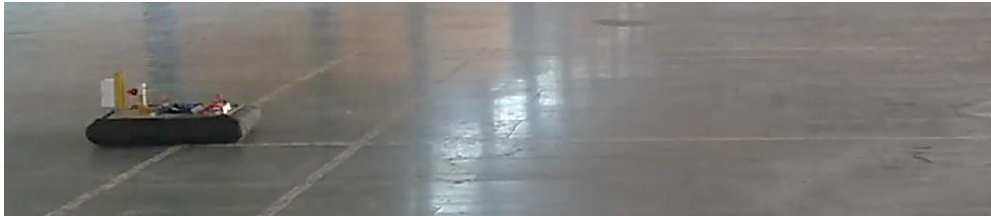
Figure 16. Testing of hovercraft in floor